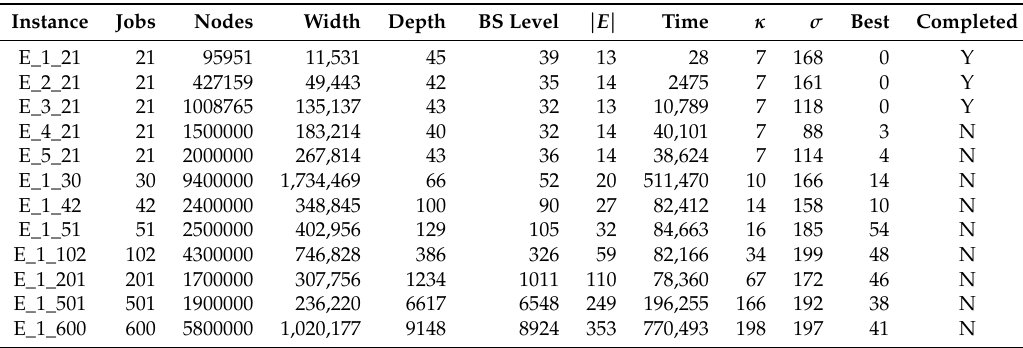
Table 12. Results for some artificial